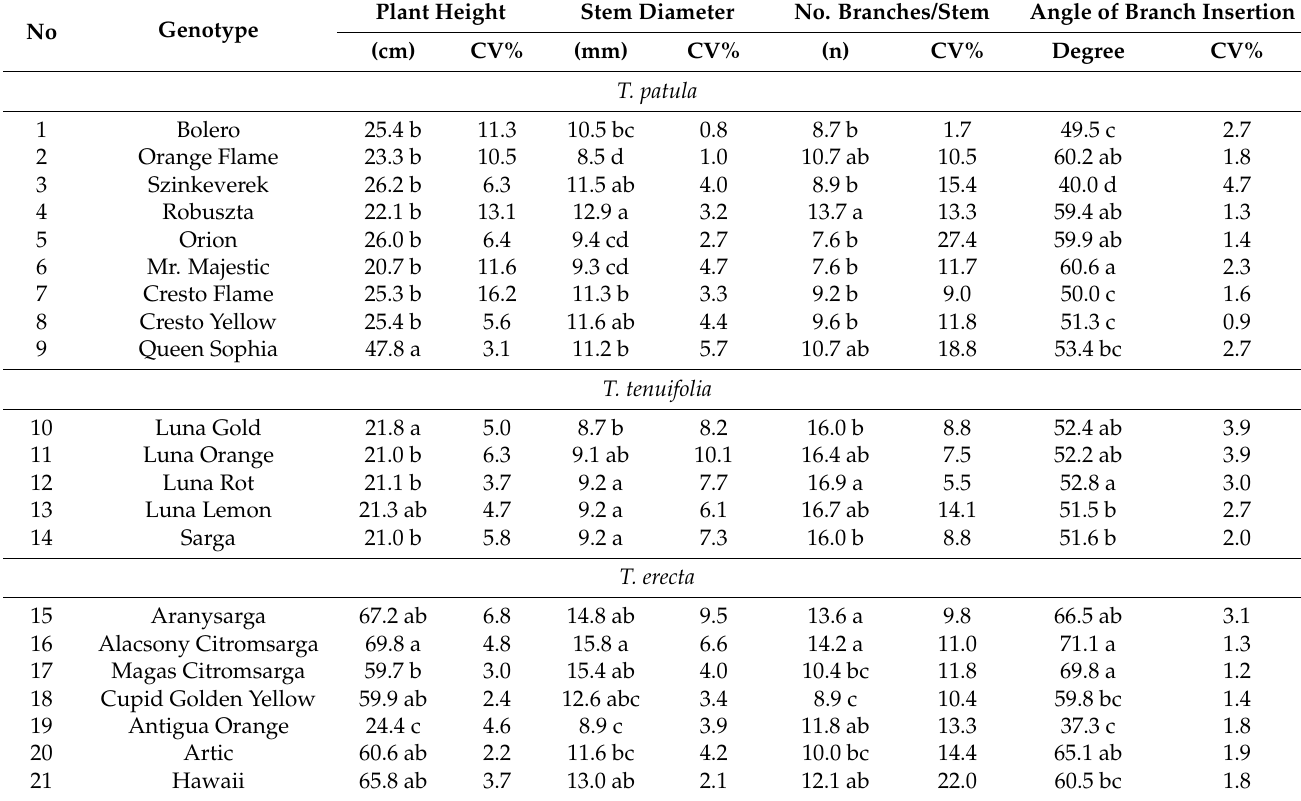
Table 2. Main plant traits and their coefficient of variation of the Tagetes